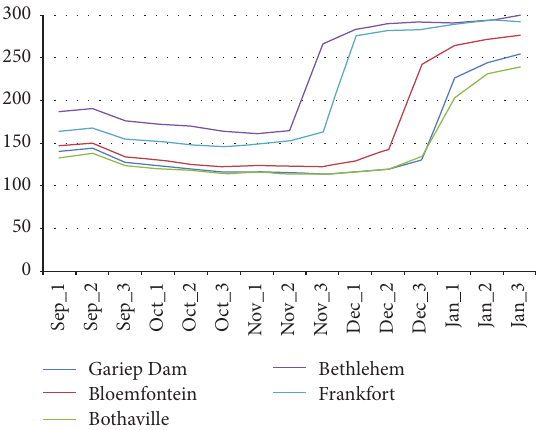
Figure 7: Length of growing period in days for a medium-late season maize variety for the Gariep Dam, Bloemfontein, Bothaville, Bethlehem, and Frankfort stations from the 1st dekad of September to 3rd dekad of